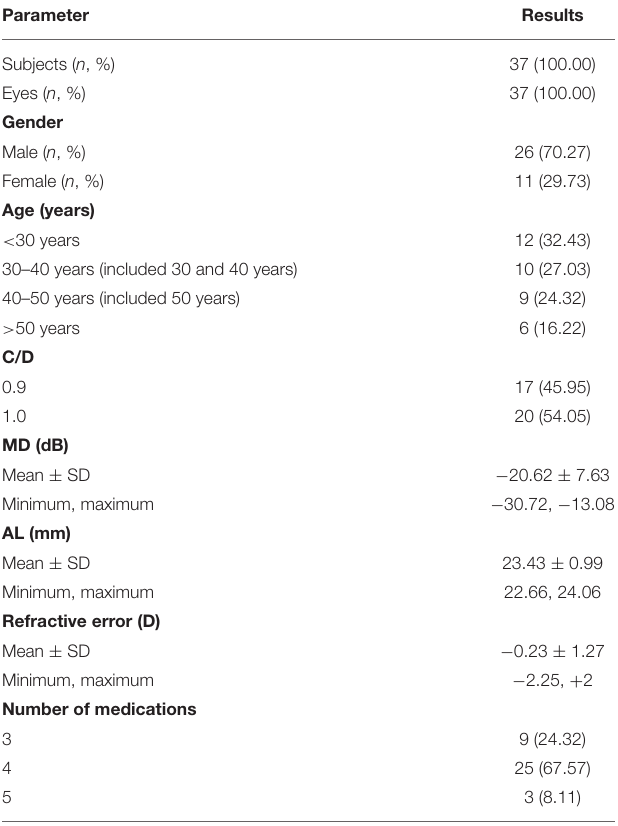
TABLE 1 | Baseline parameters for the subjects. Parameter Results